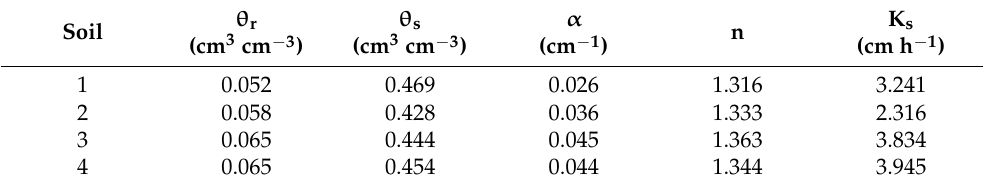
Table 2. Hydraulic parameters of the experimental soils obtained with the ROSETTA version 1.2